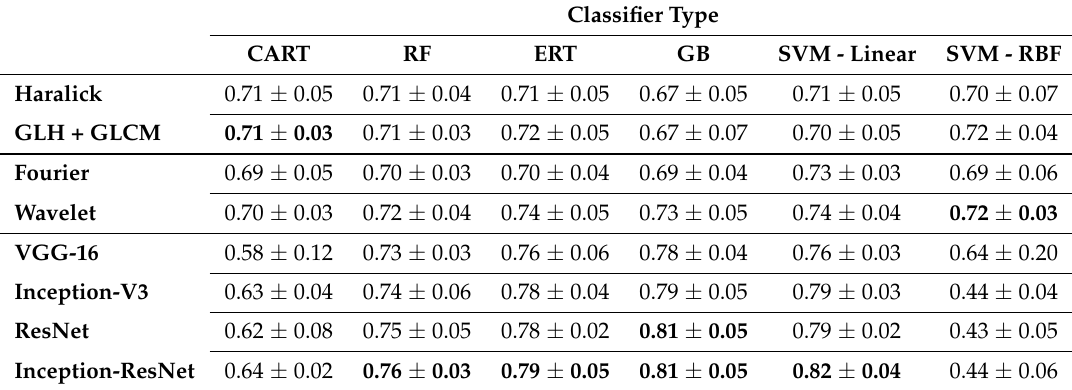
Table 5. List of the results based on combinations of features extraction methods from Section 2.2 and the classification models from Section 2.3 evaluated over a weighted F 1 score based on benign and malignant